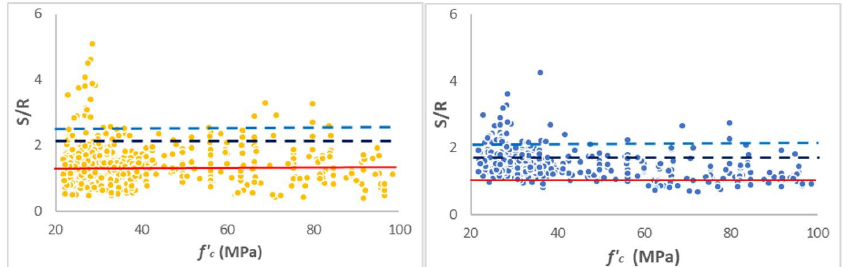
Figure 4- S/R in relation to